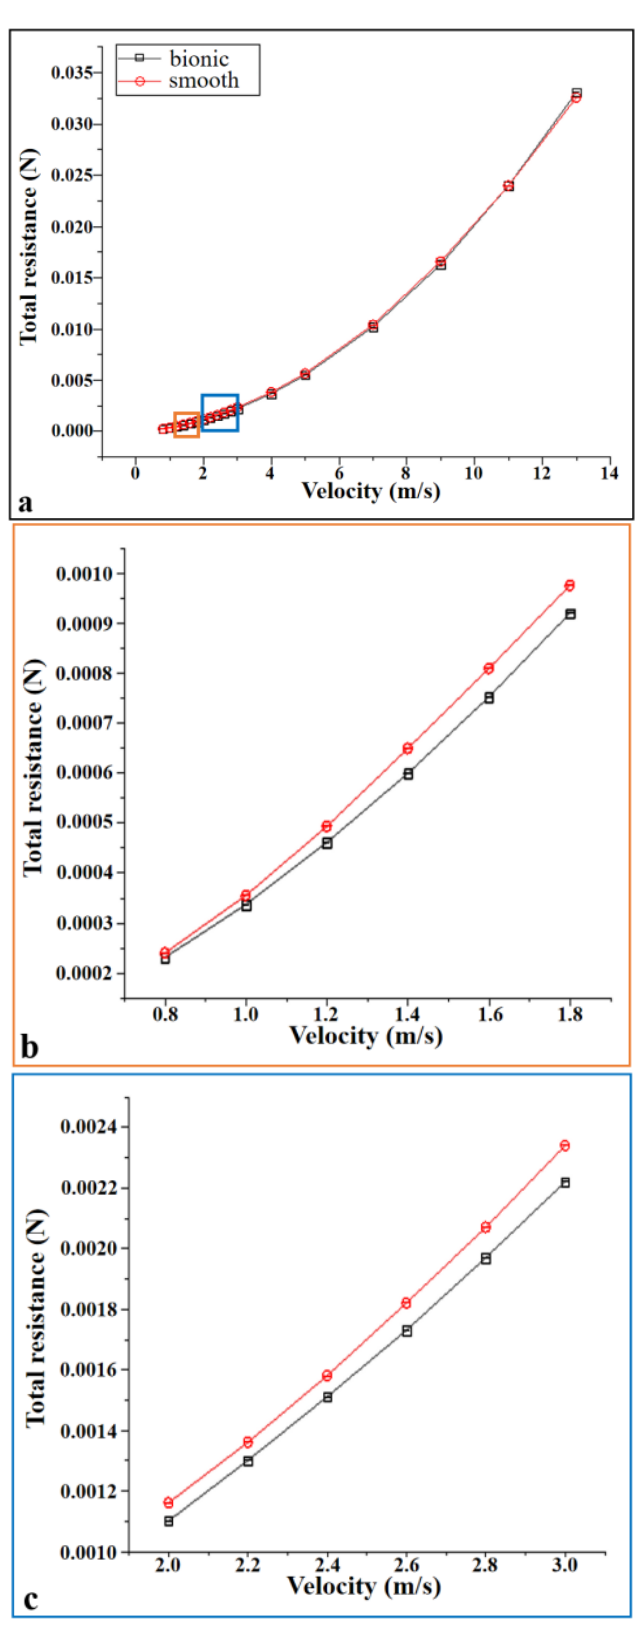
Figure 10. Flow velocity-resistance diagram. ( a ) The total resistance of both surfaces among the whole range of flow velocity. ( b ) The detailed information of the low-speed group; ( c ) The detailed information of the medium-speed group.